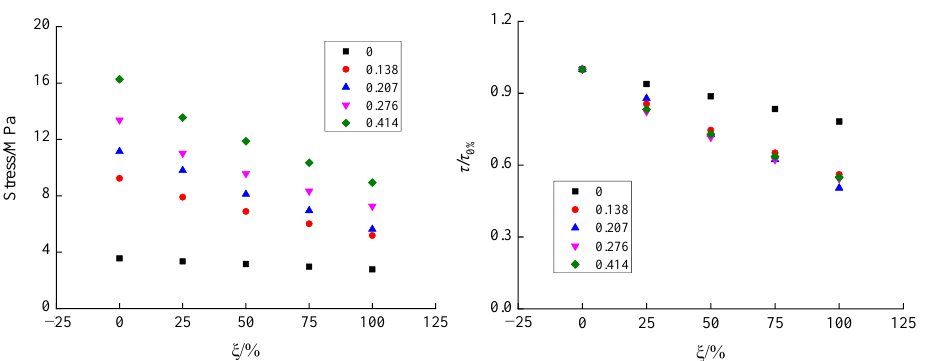
Figure 6. Variation trend of the influence of RA replacement rate on the shear stress of recycled concrete.